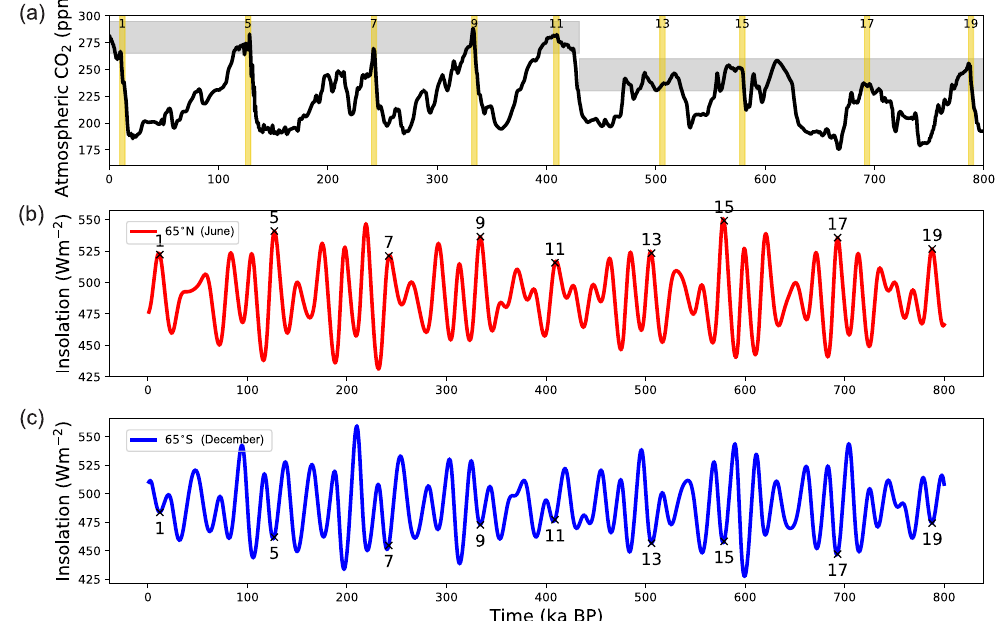
Figure 1. (a) Atmospheric CO 2 (ppm) record at EPICA Dome C (Lüthi et al., 2008) and insolation (Wm − 2 ) (b) at 65 ◦ N on 21 June and (c) at 65 ◦ S on 21 December, based on Berger